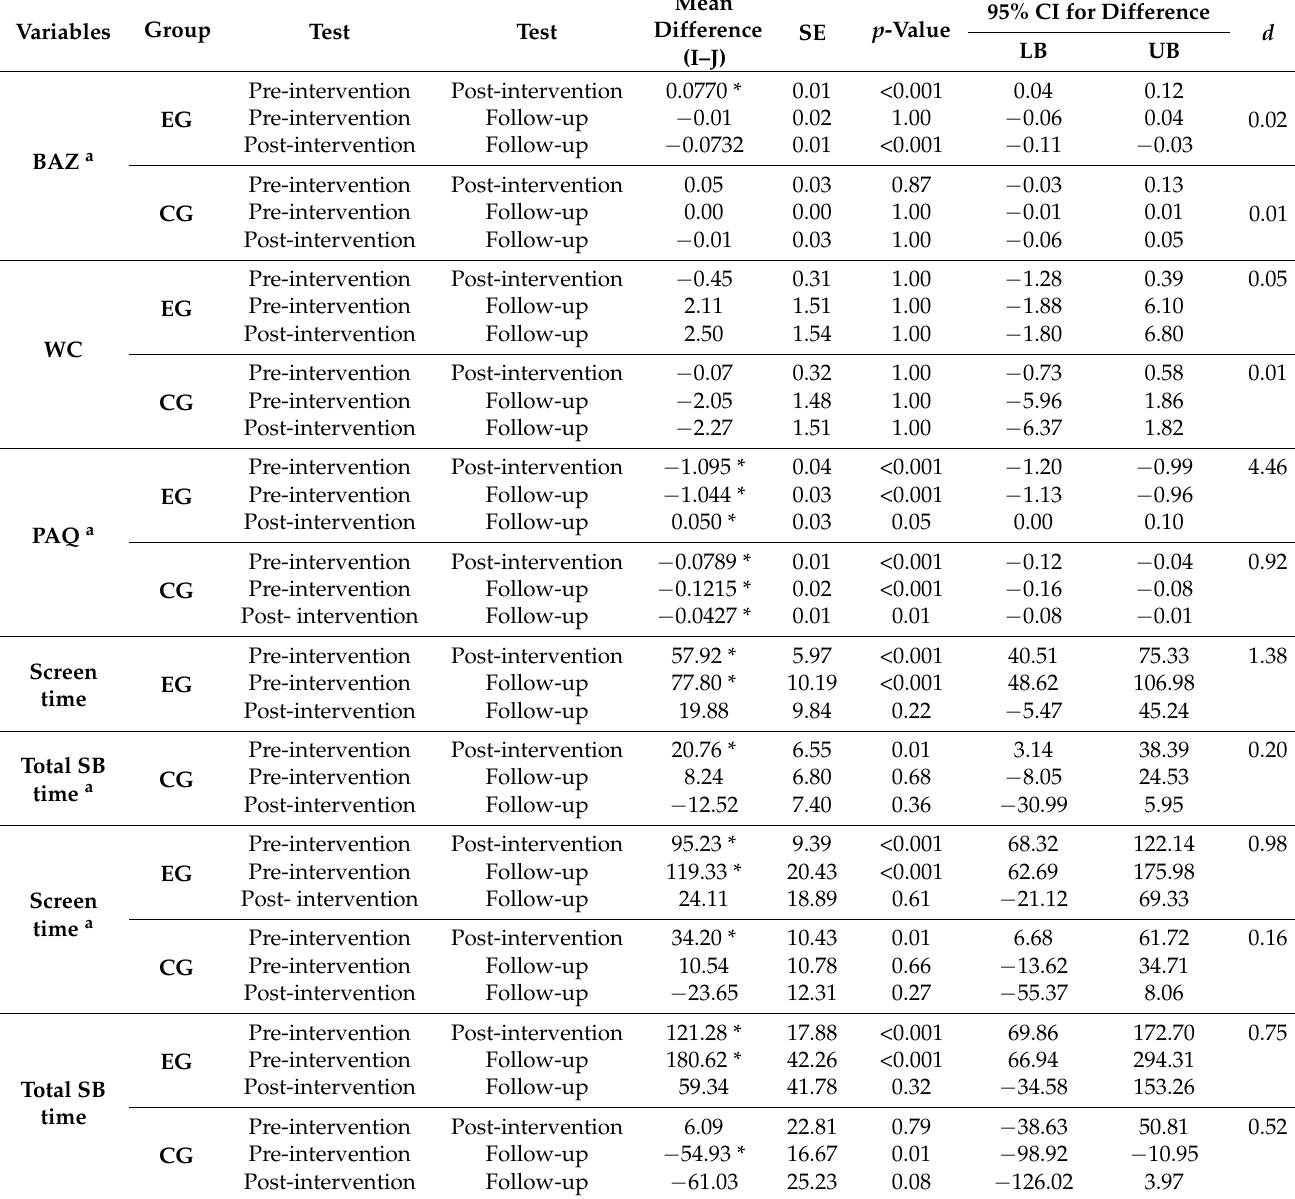
Table 3. Pairwise Comparison of BMI-for-age z-score, waist circumference, physical activity, and screen time and total sedentary behavior on weekdays and weekends, mean score over time for both